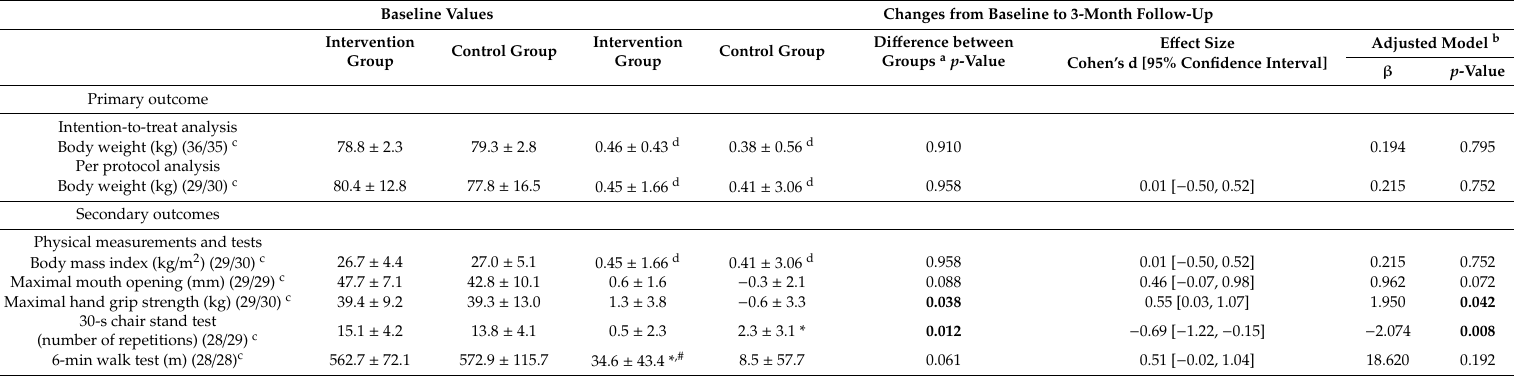
Table 3. Changes in physical measurements and tests from baseline to 3-month follow-up in the NUTRI-HAB trial. Changes from Baseline to 3-month Follow-up.